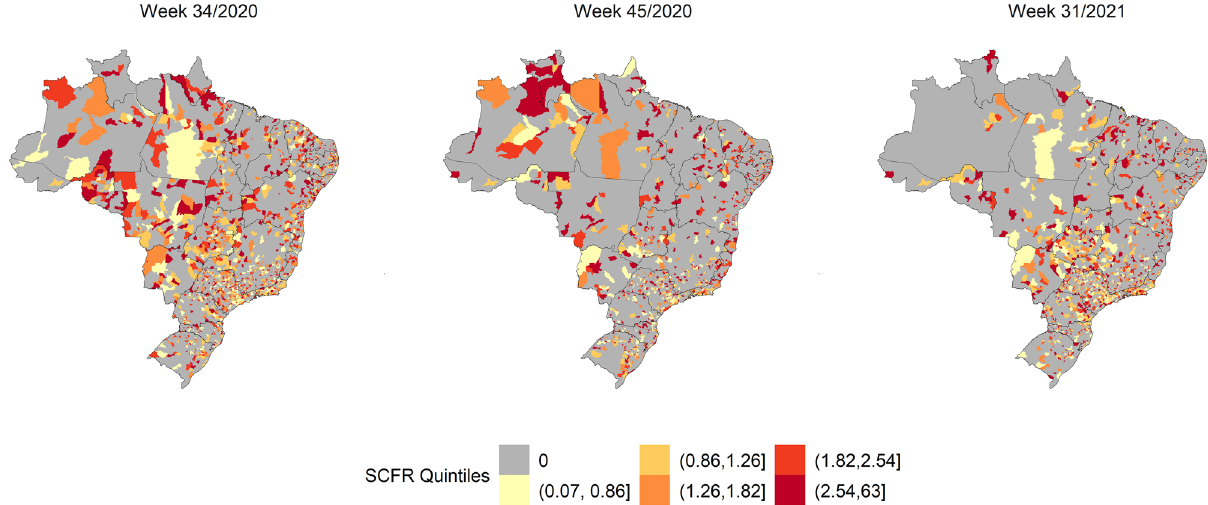
Figure 3. SCFR Quintiles by Brazilian municipalities in weeks 41/2020, 6/2021, and 24/2021. The map was generated using public domain shapefiles provided by the Brazilian Institute of Geography and Statistics (https:// geoftp. ibge. gov. br/ organ izacao_ do_ terri torio/ malhas_ terri toria is/ malhas_ munic ipais/ munic ipio_ 2021/ Brasil/ BR/ BR_ Munic ipios_ 2021. zip). The figure was generated by the authors using the R 4.0.5 software 9 and the packages ggplot2 10 , sf 11 and tidyverse 12 .